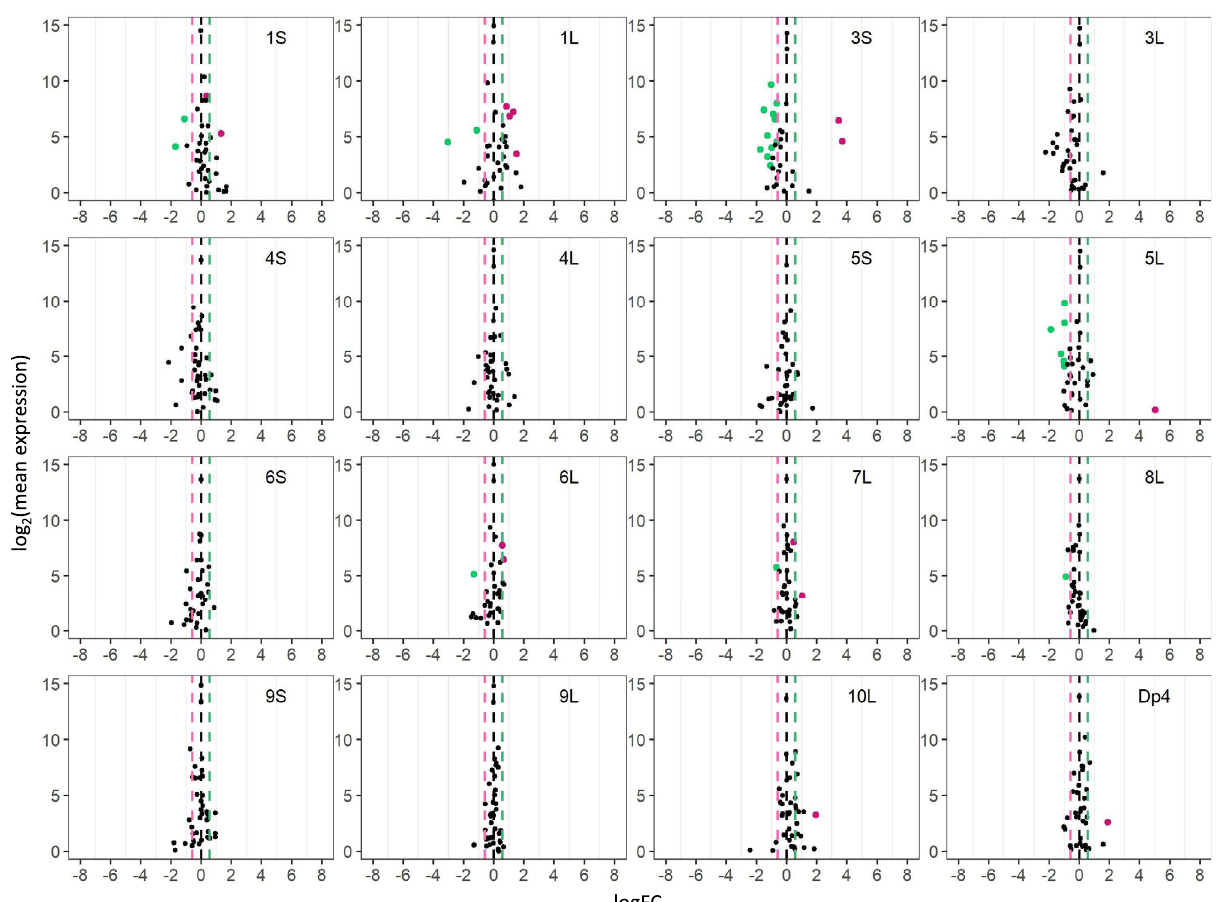
Fig. 3 Scatter plots of trans MIRNA expression in each trisomy compared with diploids (3D/2D). Analysis was conducted as described in Fig. 2. An FC of 0.67 represents the inverse ratio of MIRNA expression in trans , whereas 1.5 represents a positive modulation. These FC values are demarcated with labeled vertical lines in pink (0.67), black (0), and green (1.5). Source data are provided in Supplementary Data